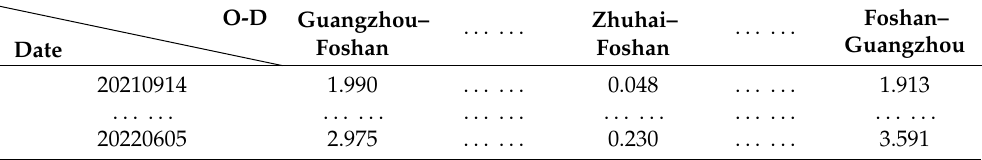
Table 5. Results of constructing time-series intercity mobility flow matrix.